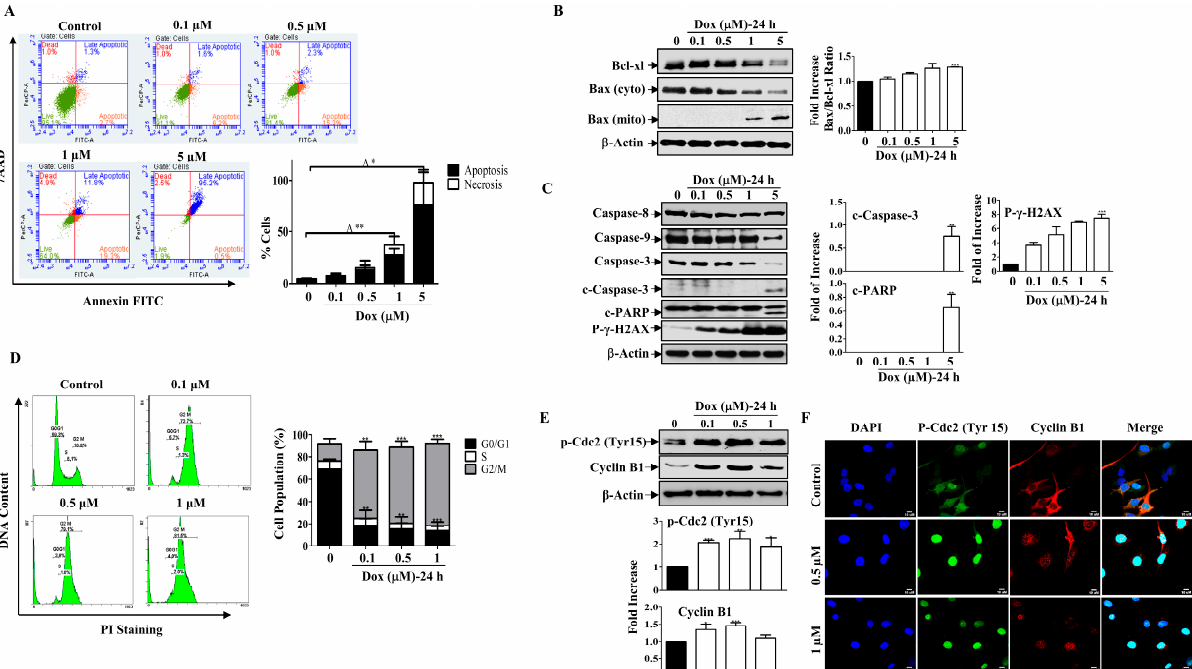
Figure 2. Dox Induces Mitochondrial Apoptosis and Cell Cycle Arrest. ( A ) MDA-MB-231 cells